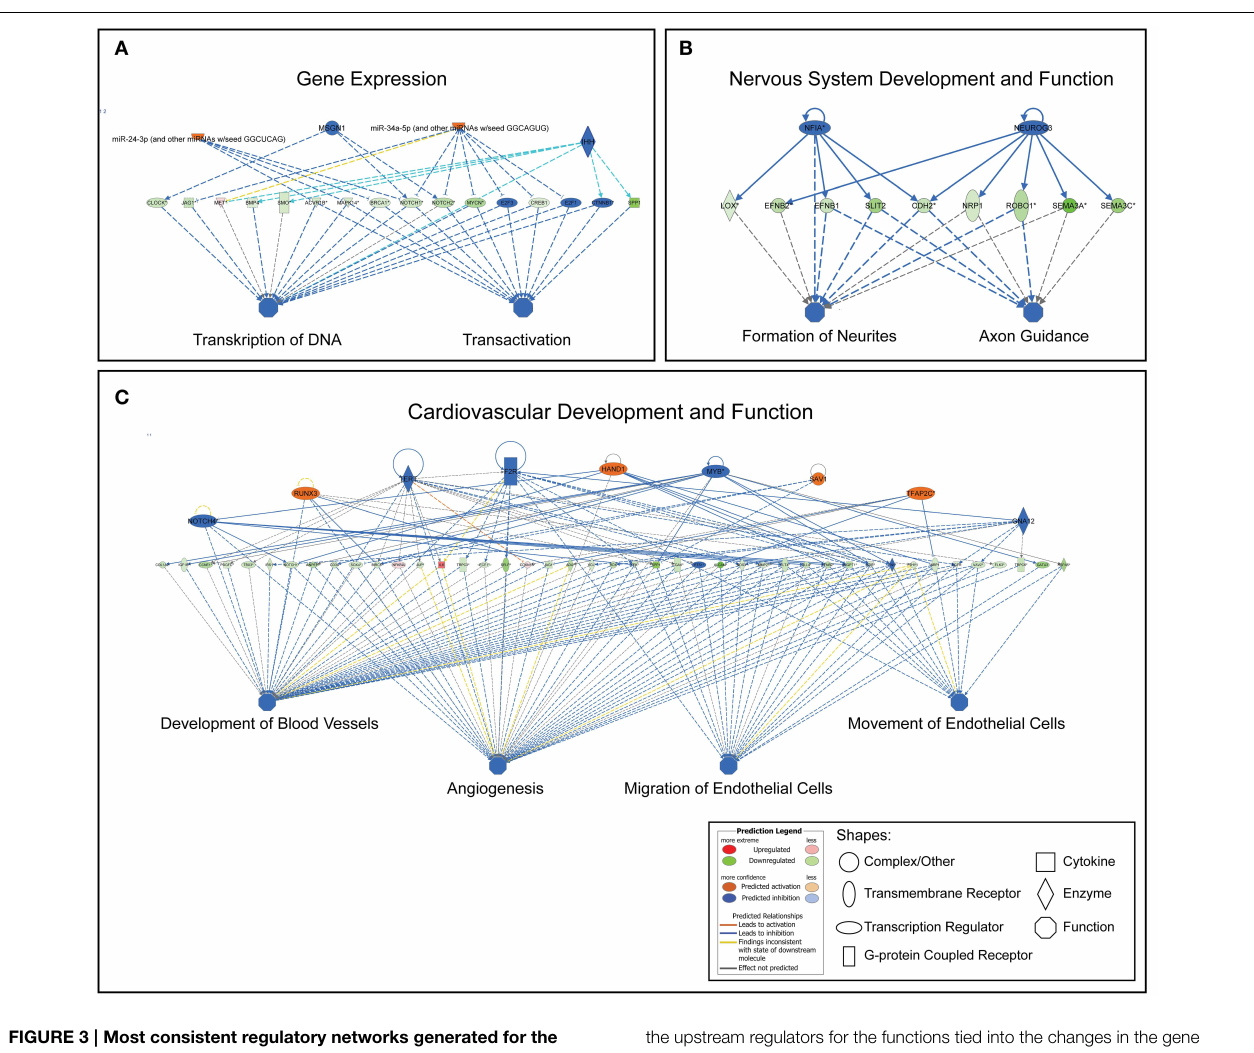
FIGURE 3 | Most consistent regulatory networks generated for the functions of gene expression (A), nervous system and development (B), cardiovascular system development and function (C). This predicts